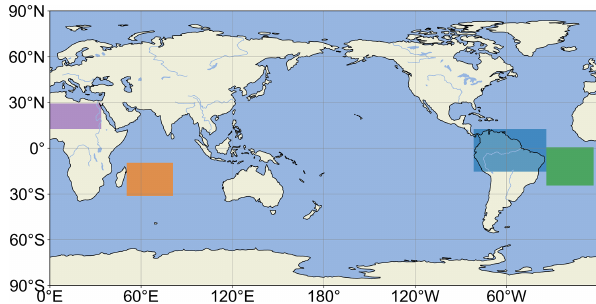
Figure 9. Four target regions for which LNO x is the major source of NO x . The four target regions are North Africa (purple), the Indian Ocean (orange), the Amazon (blue), and the South Atlantic